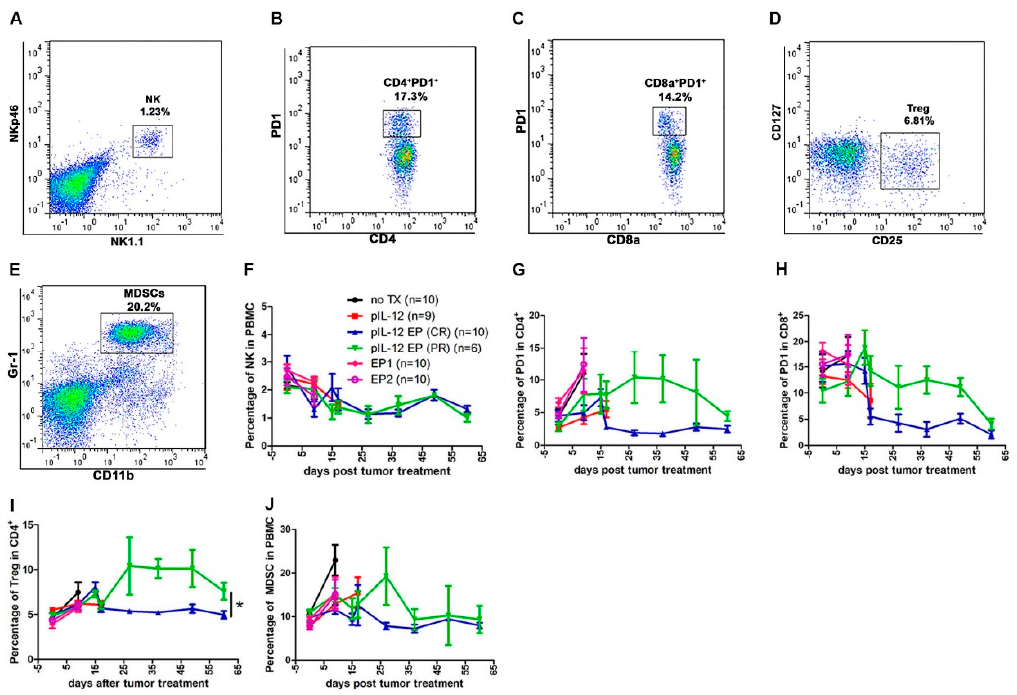
Figure 6. pIL-12 GET decreased CD4 + PD1 − , CD8 + PD1 − , Treg cells and MDSCs. ( A – E ) Representative flow cytometry gating strategy to assess immune cell response to pIL-12 GET. ( F ) Kinetics of the percentage of NK cells. ( G , H ) Kinetics of changes of exhausted CD4 + and exhausted CD8 + cells. ( I ) Kinetics of the percentage of Treg cells. ( J ) Kinetics of the percentage of MDSCs. Pooled data from two independent experiments are shown as mean +/ − SEM (animals in each group, n = 6–10). One-way ANOVA, p * < 0.05.